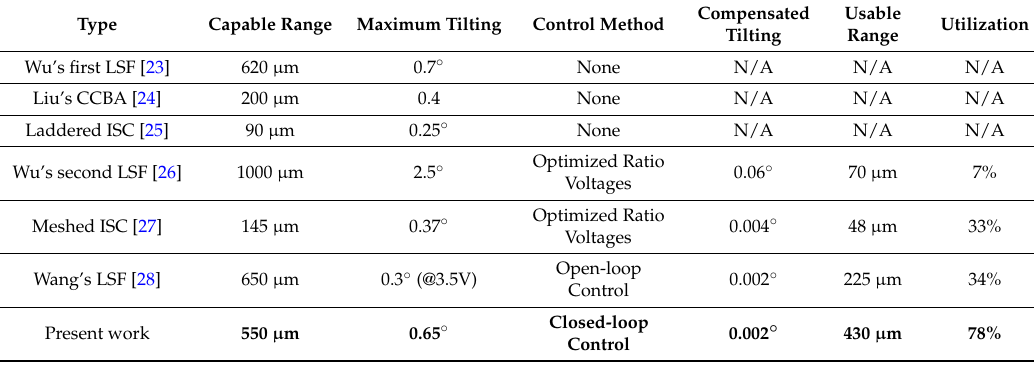
Table 1. Comparison of prior work to this work.